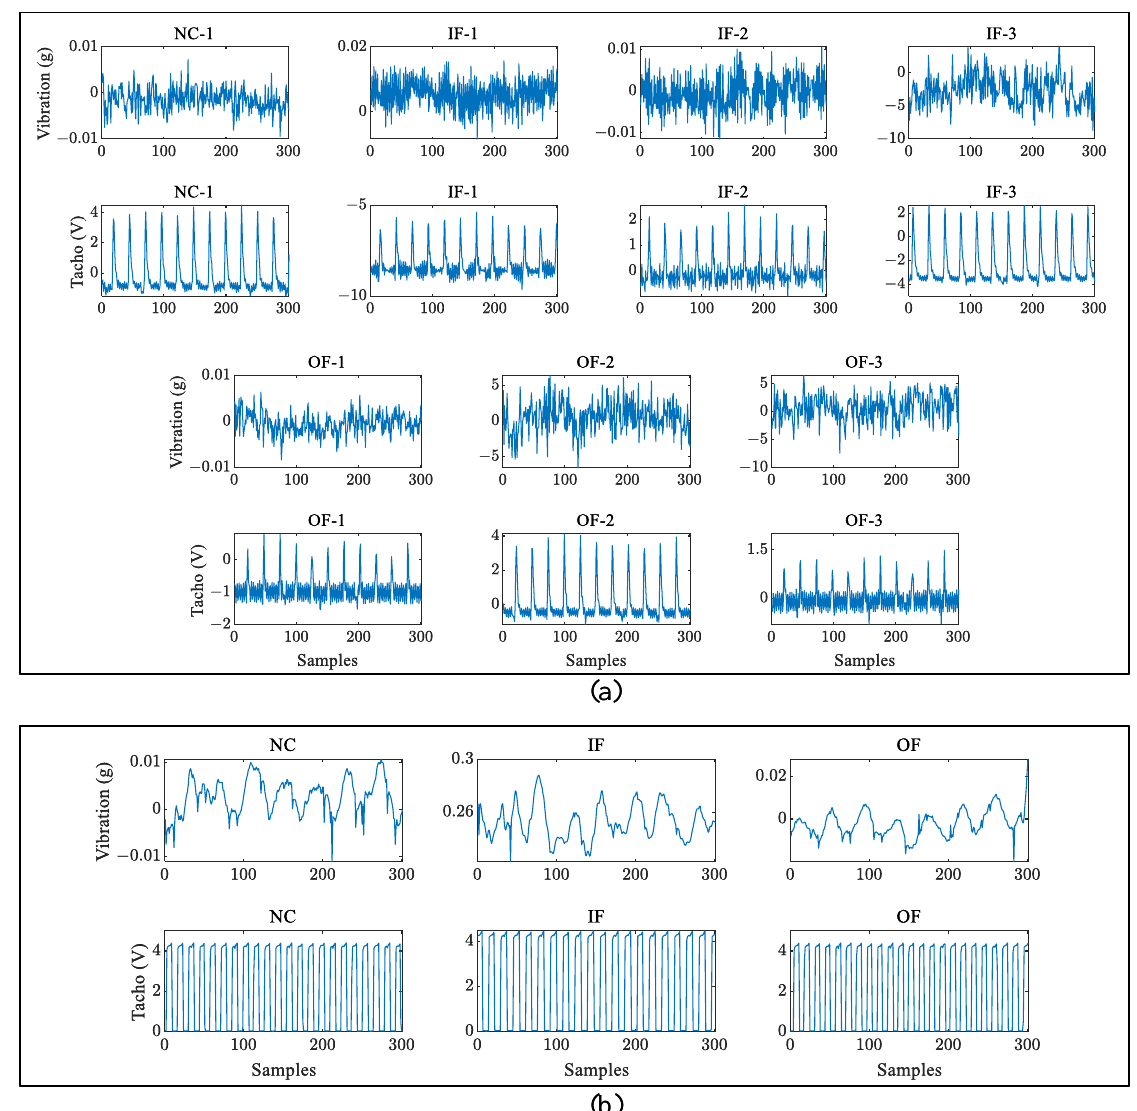
Figure 9. Part of the dataset via augmentation: ( a ) SQV dataset; ( b ) University of Ottawa